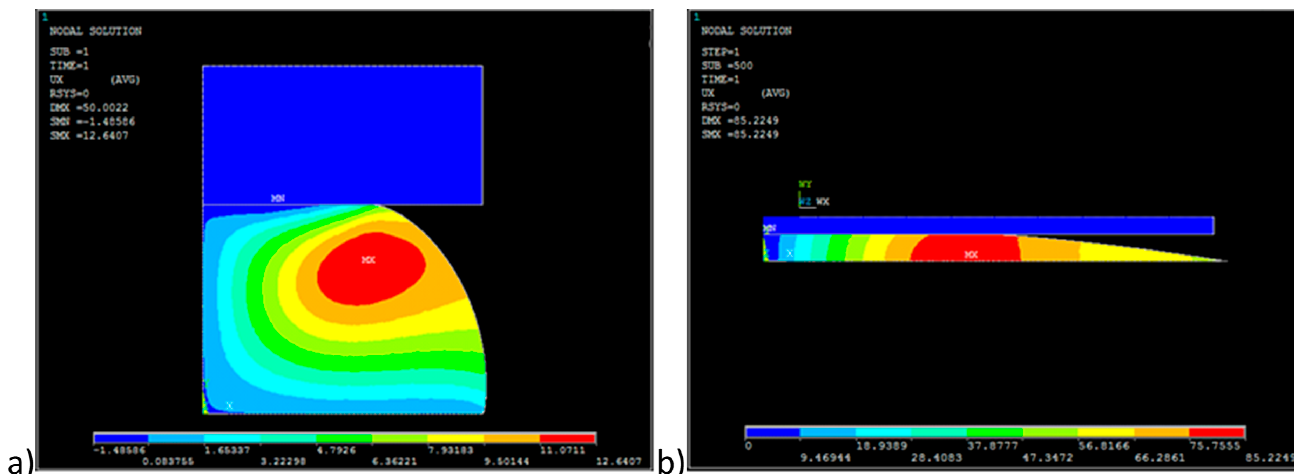
Figure 26. Exemplary distribution displacements in the horizontal direction for the contact between the face of the rigid cylinder and the PTFE: ( a ) Hemisphere; ( b ) Spherical cap.